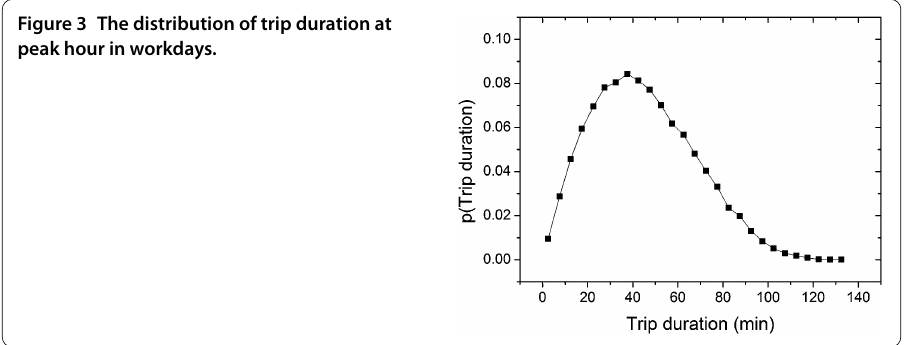
Figure 3 The distribution of trip duration at peak hour in